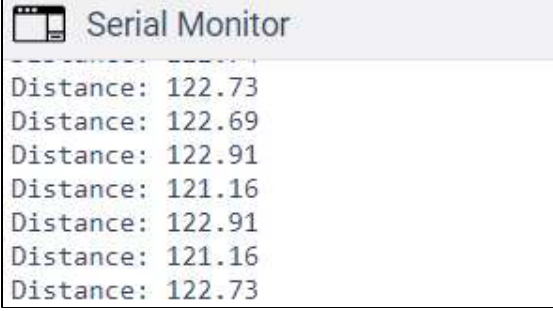
Fig. 10. Obstacle Avoidance System Reading 2